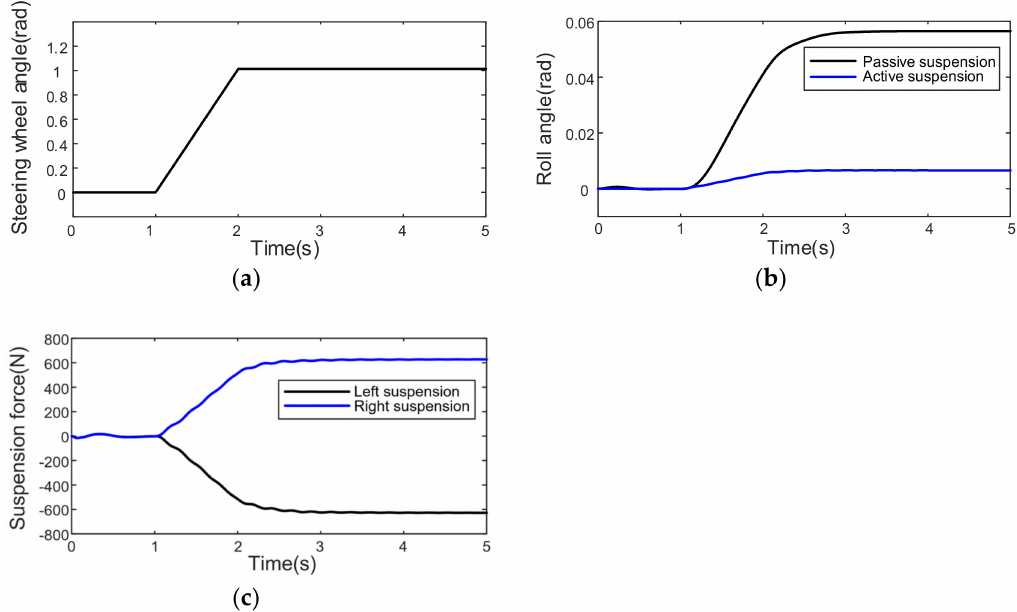
Figure 6. Simulation of active suspension roll controller. ( a ) steering wheel angle; ( b ) roll angle; and ( c ) suspension